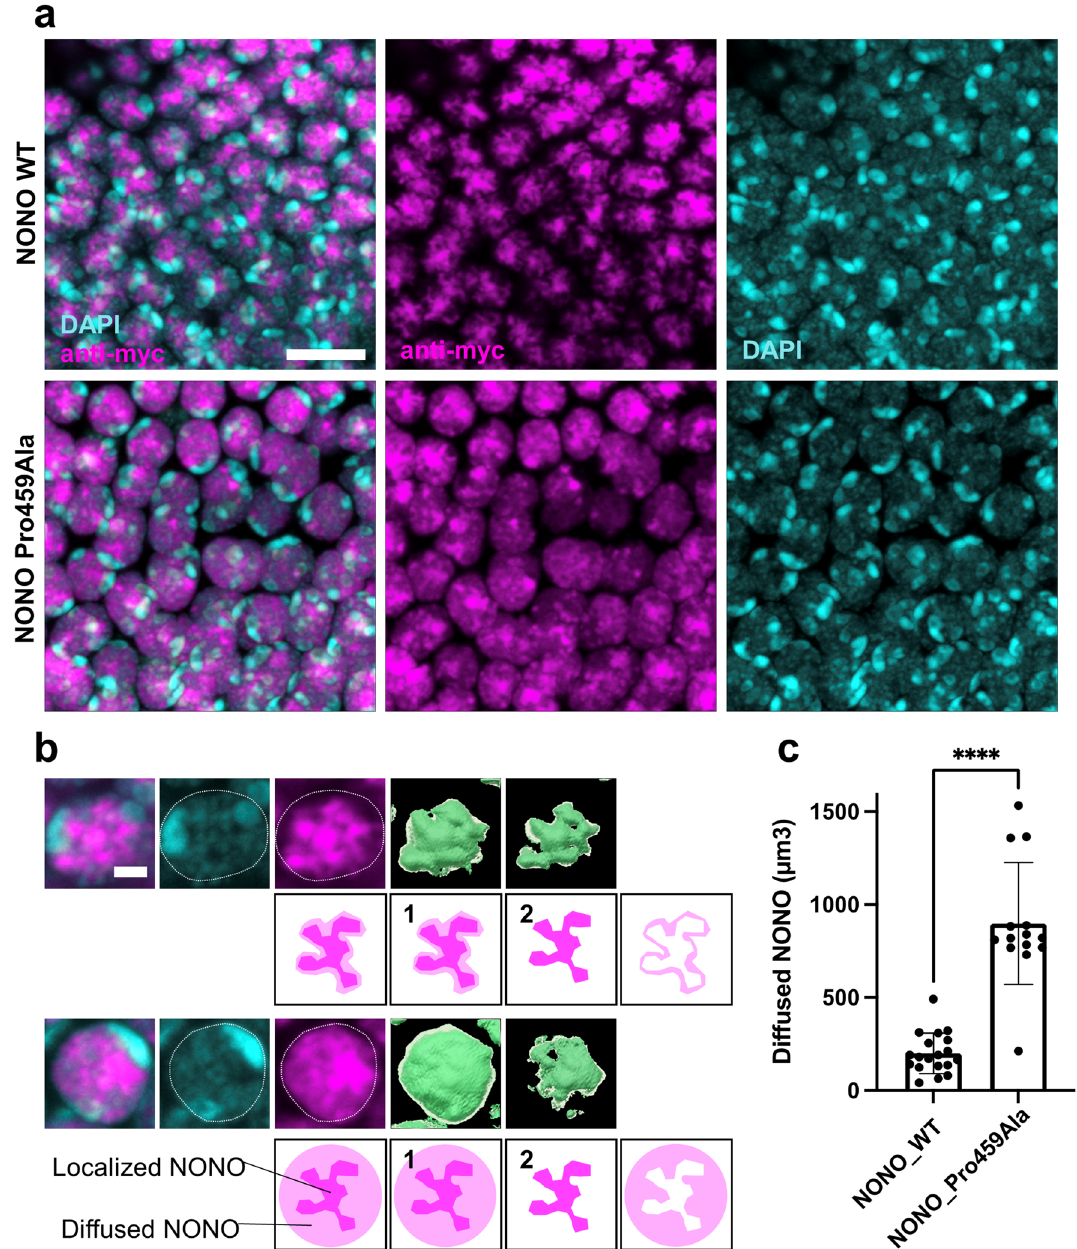
Figure 3. Localization pattern of NONO variant in Drosophila neuron. ( a ) Cell bodies of Kenyon cells in Drosophila brain. Wild-type NONO and Pro459Ala NONO are expressed. The localization pattern of Myc- NONO (magenta) was stained with anti-Myc antibody using immunohistochemistry. The nuclei were visualized using DAPI (cyan). Scale bar = 5 µm. ( b ) Comparative localization patterns of NONO variants in a Kenyon cell. Myc-NONO is shown by anti-myc antibody and the nucleus is visualized using DAPI. NONO is strongly localized in the weak region of DAPI. The Imaris image analysis software extracted (1) Myc signals, including the strong and weak signals, and (2) only strong Myc signals. They were then converted into numerical form as volumes (µm 3 ). Diffuse signals in the nucleus were then calculated by subtracting (2) from (1). Scale bar = 1 µm. ( c ) Quantification results of the diffuse signals in the nucleus (µm 3 ) in Myc-NONO WT ( n = 19) and Myc- NONO Pro459Ala ( n = 14). Data represent the mean ± SD. Statistical comparisons were conducted using a nonparametric Mann–Whitney test. *** P <